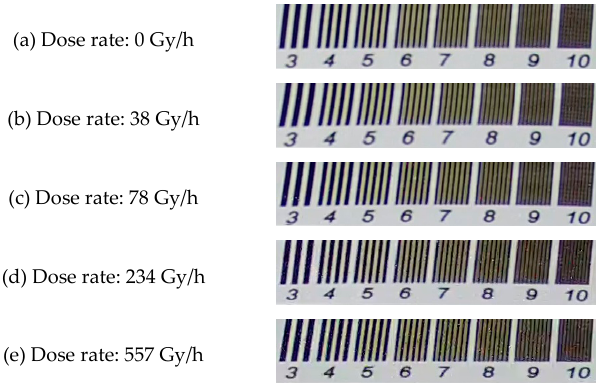
Figure 9. Resolution test images of 4T-APS at irradiation dose rates of 38, 78, 234, and 557 Gy/h. Noises appeared in these images; no blur and resolution decrease was observed in these images, and the boundary of the black and white stripes became more obvious during the γ -ray irradiation.